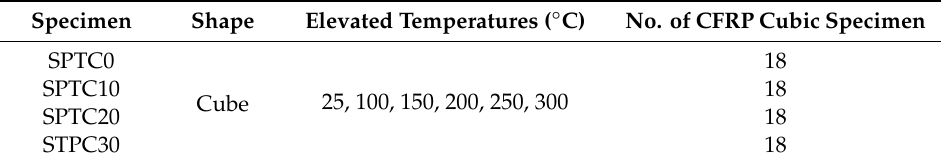
Table 8. The number of cubic test specimens at elevated temperatures.